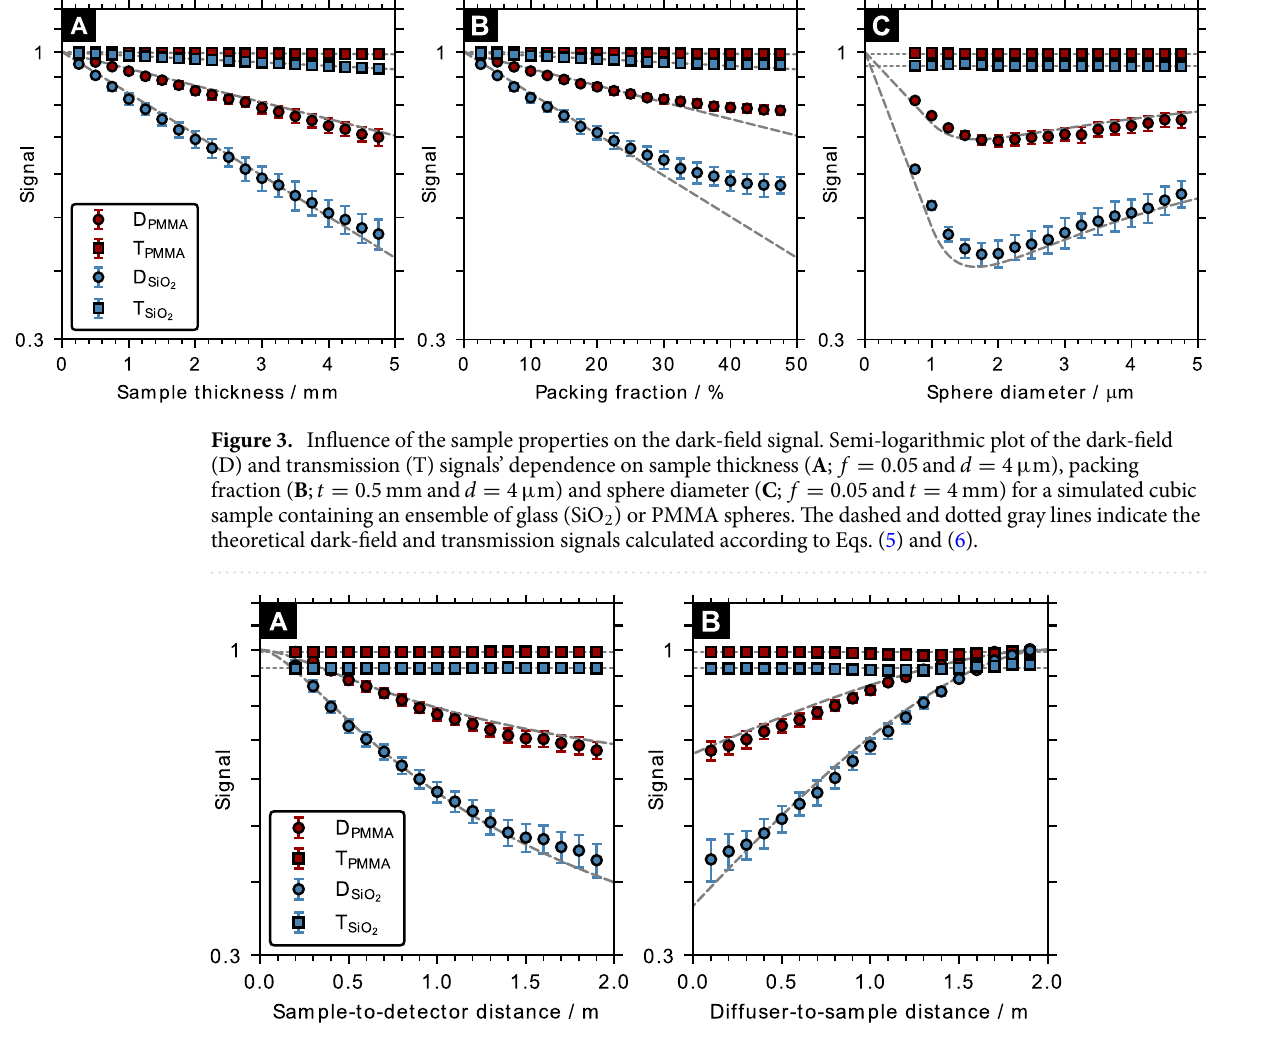
Figure 4. Influence of the setup geometry on the dark-field signal. Semi-logarithmic plot of the dark-field (D) and transmission (T) signals’ dependence on ( A ) sample-to-detector distance and ( B ) diffuser-to-sample distance for a cubic sample containing an ensemble of glass (SiO 2 ) or PMMA spheres ( f = 0.05 , t = 5mm and d = 4 µ m ). The dashed and dotted gray lines indicate the theoretical dark-field and transmission signals calculated according to Eqs. (5) and